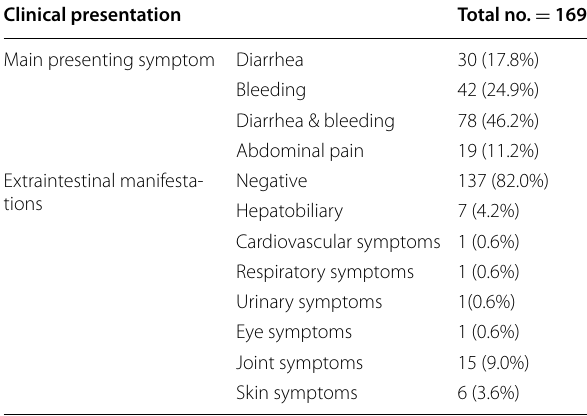
Table 5 Symptoms of the patients at index presentation Table 6 Laboratory parameters of the patients at index